Question: Summarize what this figure shows in one sentence.
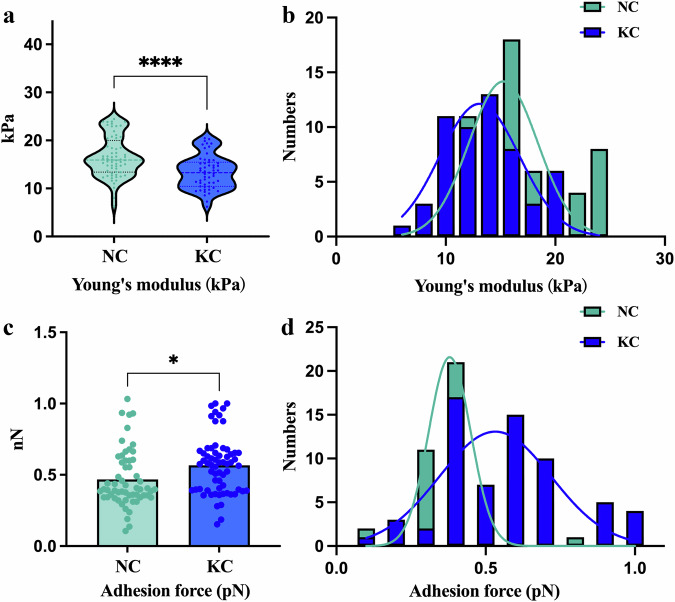
Answer: Analysis of the Young’s modulus and adhesion force in corneal stromal cells with NC and KC. a Violin plot illustrating the distribution of Young’s modulus. b Histogram comparison of the Young’s modulus among the two groups. c Scatter plots of the adhesion force with mean ± error bars across groups. d Histogram comparison of the adhesion force among the two groups.